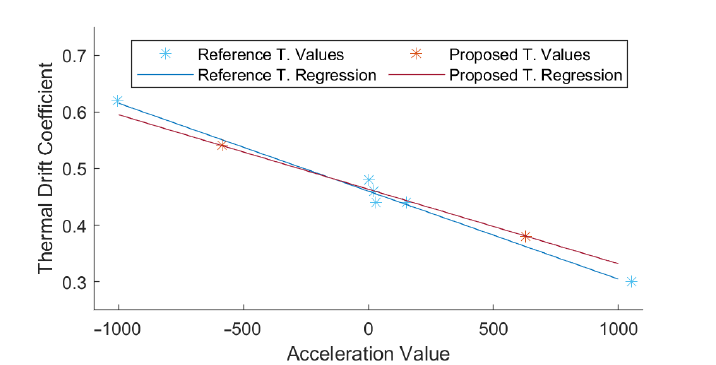
Figure 12. Data points and thermal drift coefficients regressions for the proposed and reference techniques.